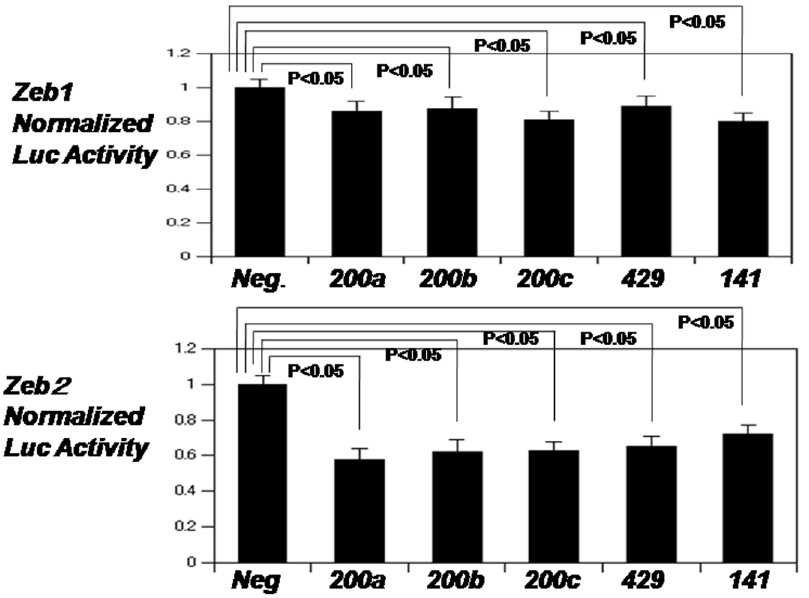
Figure 3. miR-200 family members target the transcriptional repressors ZEB1 and ZEB2. Normalized activity of luciferase reporter with the ZEB1 or ZEB2 3 9 UTR in HK-2 cells in the presence of co-transfected negative control pre-miR or miR-200 family individually. Luciferase activity was measured after 24 hours. The data are mean 6 S.E. of triplicates and are shown as the ratio of firefly to Renilla luciferase activity. P , 0.05: HK-2 cells in the presence of co-transfected miR-200 family compared with negative control pre-miR.